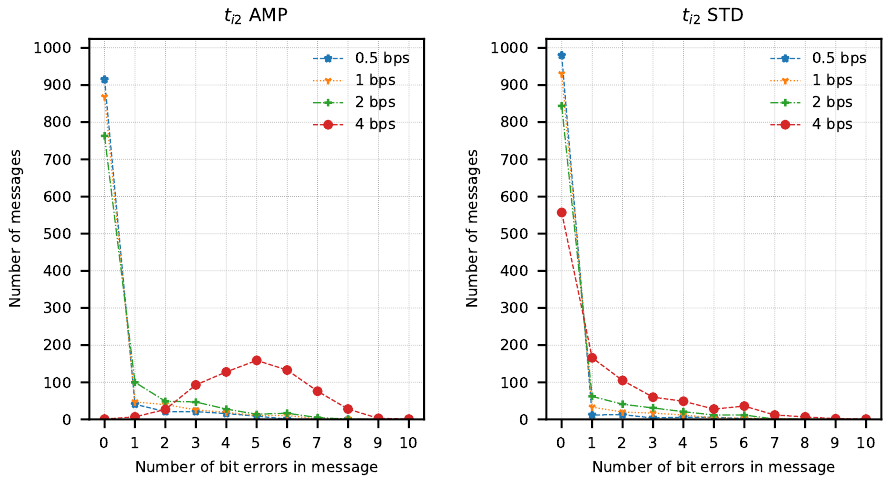
Figure 18. Number of bit errors in messages transmitted with t i 2 set calculated with amplitude analysis method (AMP) and amplitude variance analysis method